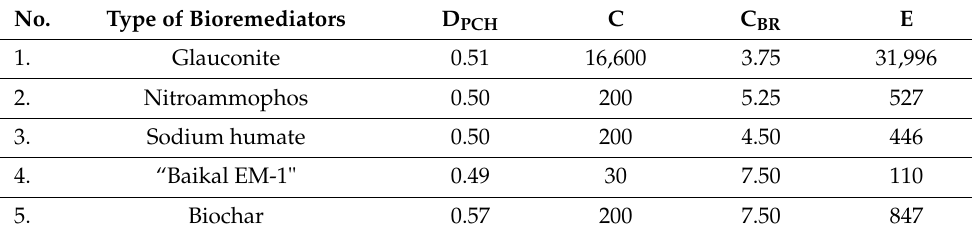
Table 5. Economic efficiency (E) of using various bioremediators of different natures, USD · 10 3